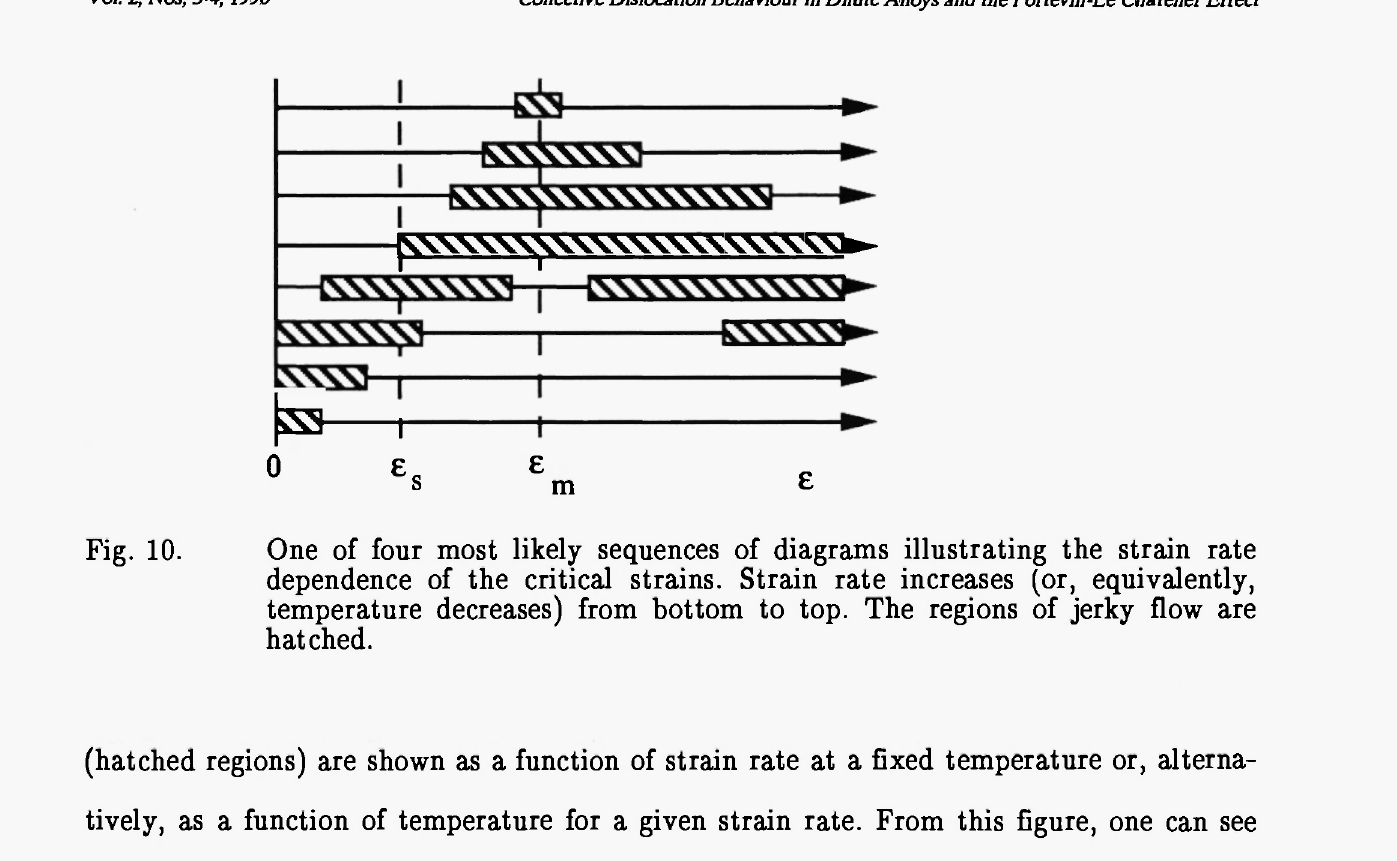
One of four most likely sequences of diagrams illustrating the strain rate dependence of the critical strains. Strain rate increases (or, equivalently, temperature decreases) from bottom to top. The regions of jerky flow are